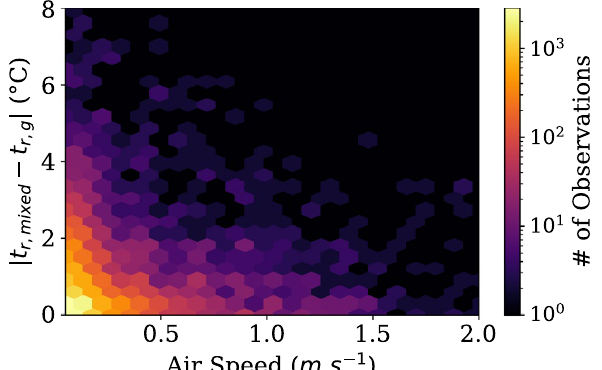
Figure 1. Distribution of potential error in t r reported in the ASHRAE Thermal comfort database II when comparing the reported t r compared to the t r calculated when accounting for mixed convection as presented in this paper. The color at each location is determined by the measurement